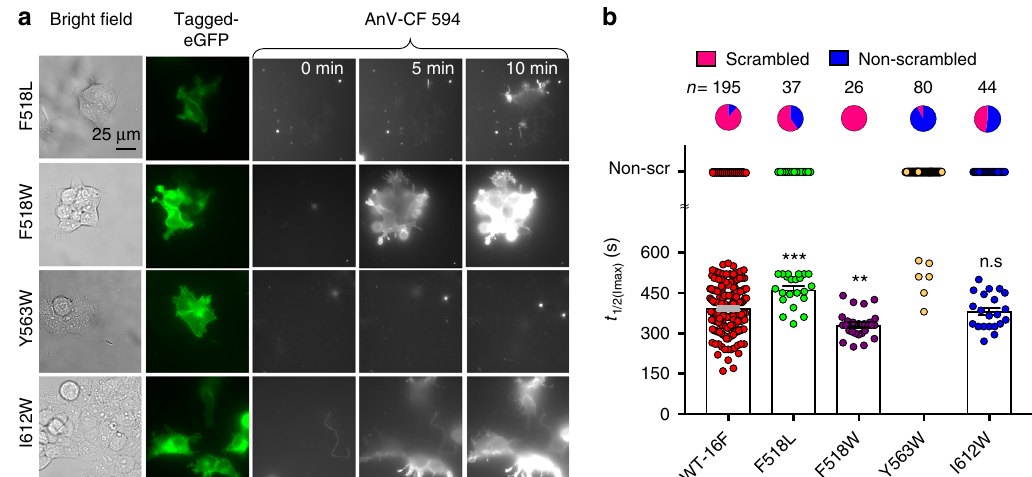
Fig. 4 Bulky hydrophobic mutations at the inner gate hinder TMEM16F lipid permeation. a Representative images of ionomycin-induced scrambling activity of TMEM16F-knockout HEK293T cells expressing eGFP-tagged TMEM16F-F518L, F518W, Y563W, or I612W. CF 594-tagged-AnV signal representing phospholipid scrambling was recorded by time-lapsed imaging for 10-min post 5 µ M ionomycin application (0 min) at a 5-s acquisition interval. Scale bars, 25 µ m. b Ionomycin-induced CaPLSase activity for WT- and mutant- TMEM16F quanti fi ed by t 1/2(Imax) . Each data point represents one cell and n is the total number of cells measured. The pie charts illustrated the percentages of ionomycin-induced scrambling cells. The cells that did not exhibit ionomycin- induced CaPLSase activity were denoted as non-scr (non-scrambling) and are excluded from statistical analysis. As a majority of Y563W-expressing cells does not scramble, mean and SEM are not assigned for this mutation. Statistical analysis was performed using one-way ANOVA with Tukey ’ s multiple comparisons test. ***: p = 0.0006; **: p = 0.0013; ns: not signi fi cant ( p = 0.9167). Error bars indicate SEM. All of the experiments based on AnV labeling were done in Ca 2 + -containing buffer. Source data are provided in the Source Data fi